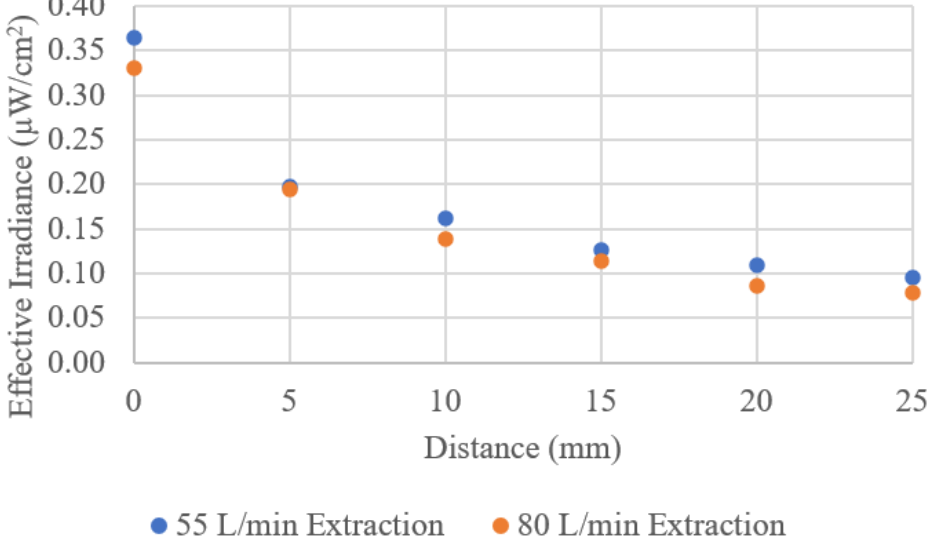
Figure 4. Effective irradiance against vertical distance from the SteriPlas torch.